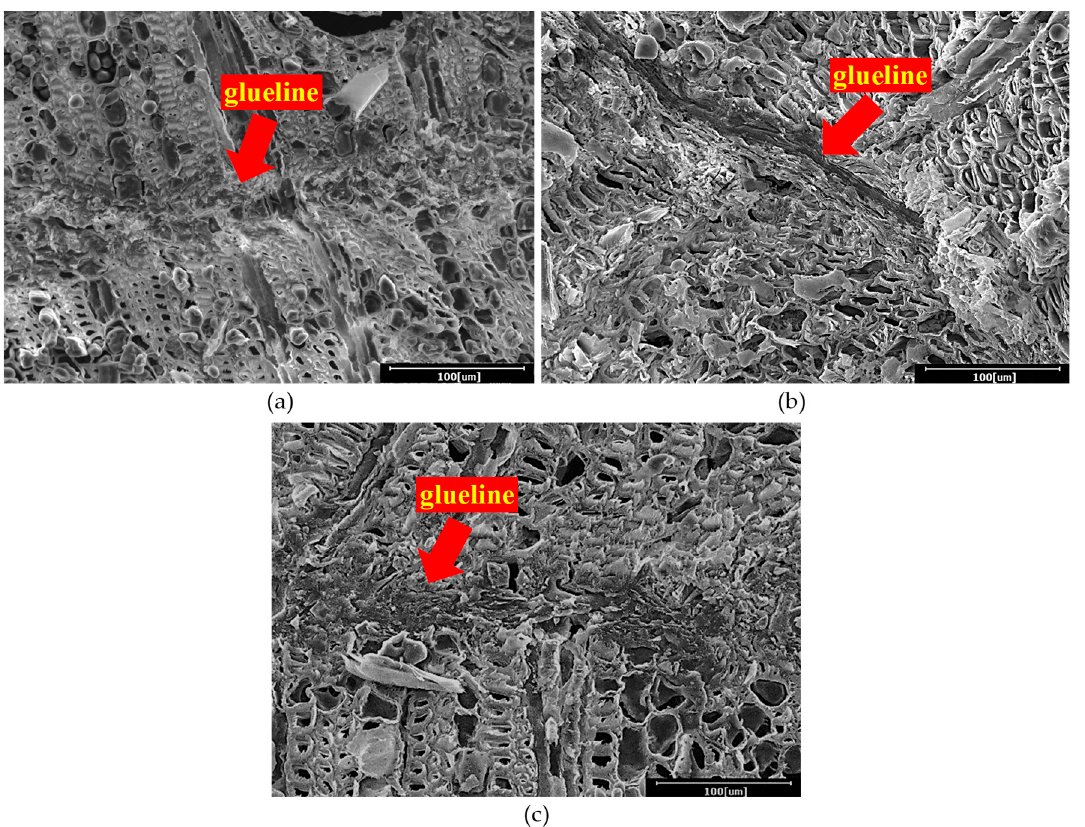
Figure 3. Glueline of rubberwood LVL observed using SEM with 500× magnification; LVL produced with ( a ) 200; ( b ) 240; and ( c ) 280 g/m 2 glue spread rate.